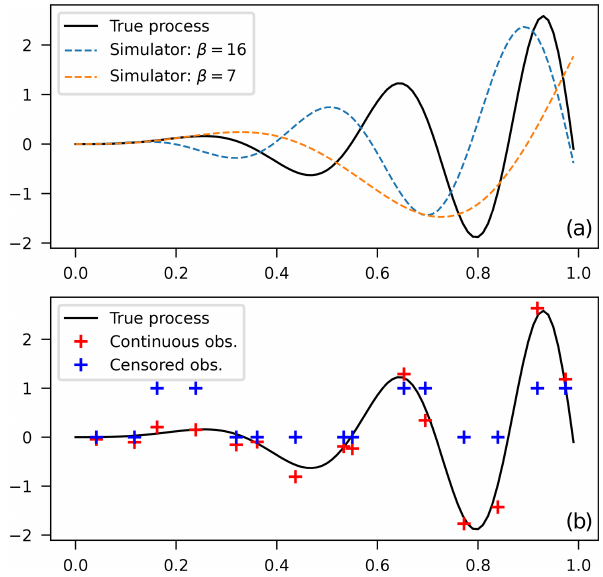
Figure 1. (a) Synthetic true model and realizations of computa- tional model runs and b) uncensored and binary observations of the true